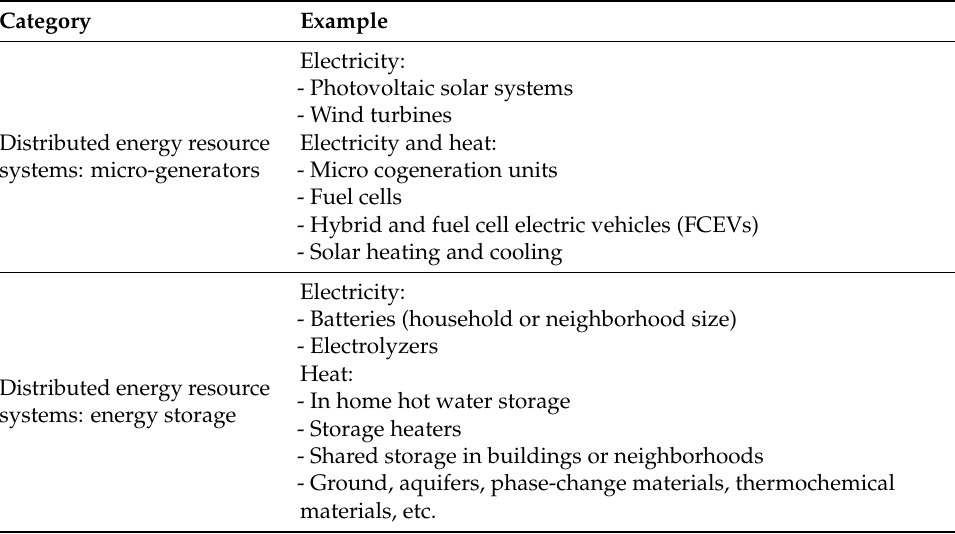
Table 2. Technologies layers in a smart energy system (adapted from